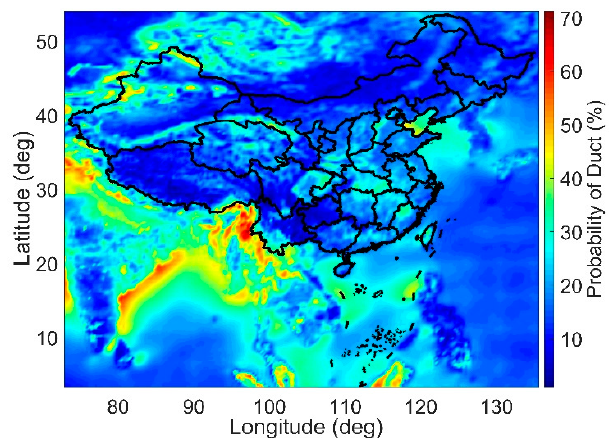
Figure 4. Map of the ducts’ likelihood of occurrence.